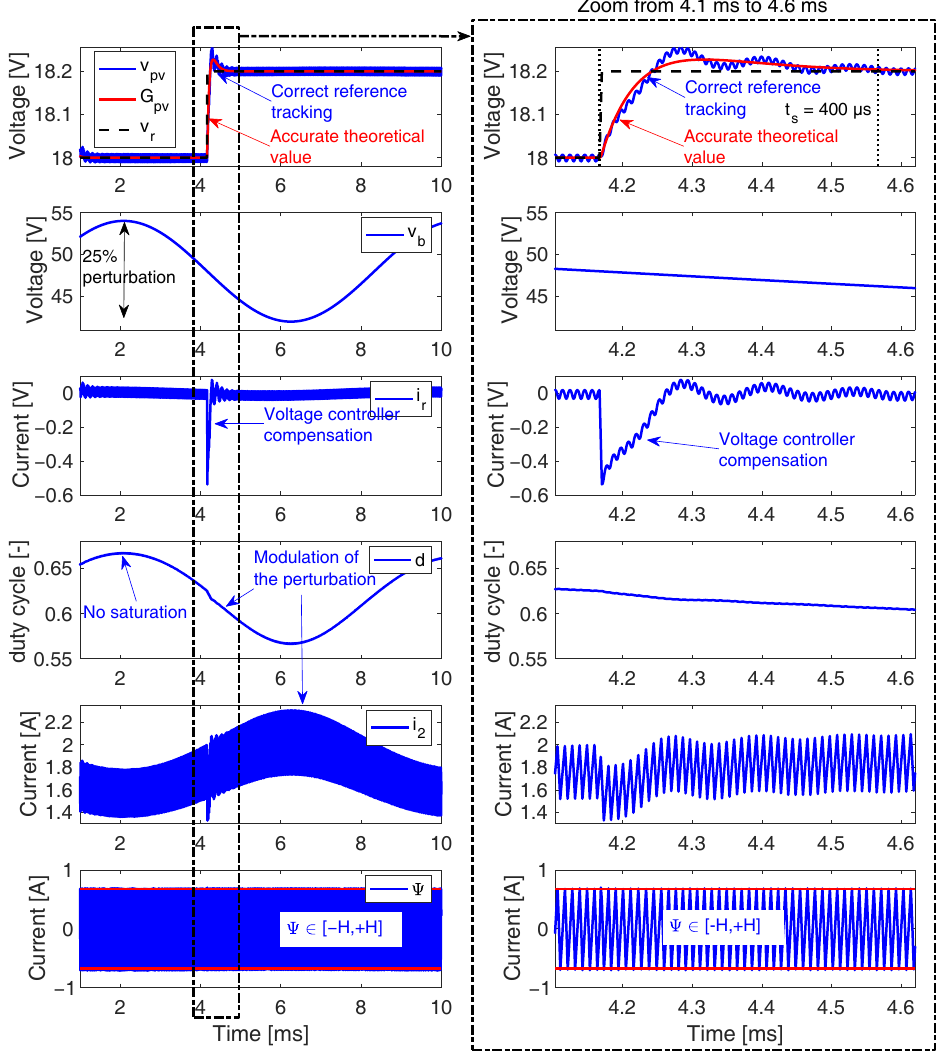
Figure 17. Dynamic performance of the proposed control